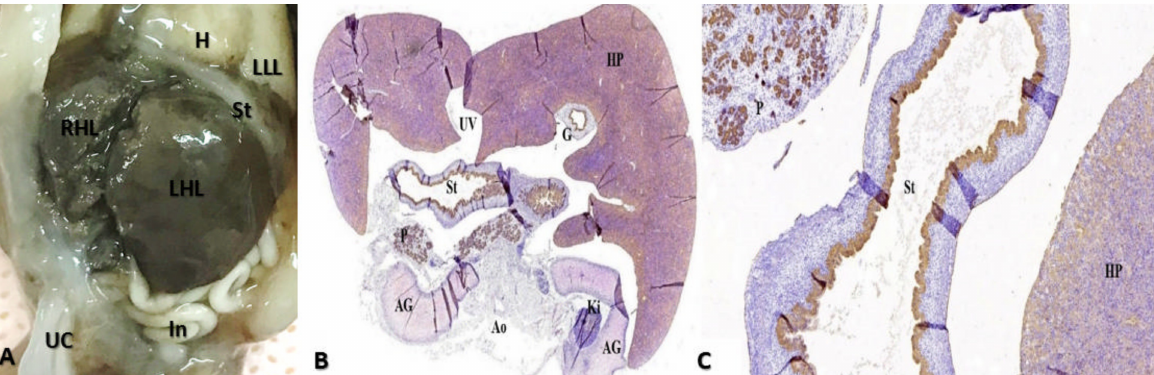
Figure 8. Anatomic and histopathological aspects of FT organs. ( A ): Anatomopathological specimen showing fetal liver which occupies most of the abdominal cavity. ( B , C ): Transverse section at the level of the abdomen. We can identify: the hepatic parenchyma located anteriorly, with the disorganized hepatocyte cords, weakly immunolabeled with CK AE1-AE3, the stomach (St) at which the gastric epithelium was intensely immunolabeled, the pancreas (P) with immunoreactive acinar cells, the two adrenal glands (AG) and one kidney (Ki). Moreover, part of gallbladder (G) are immunolabeled. Immunohistochemical staining with anti-CK antibody AE1-AE3; ( B ) the hepatic parenchyma (HP) is observed, with the disorganized hepatocyte cords, weakly immunolabeled with CK AE1-AE3, the stomach (St) with the gastric epithelium intensely immunolabeled, the pancreas (P) with immunoreactive acinar cells. Immunohistochemical staining with anti-CK antibody AE1-AE3. CK: Cytokeratin, HP: hepatic parenchyma, UV: umbilical vein, G: gallbladder, St: stomach, AG: adrenal glands, Ao: Aorta, Ki: kidney, In: intestine, UC: umbilical cord, RHL: right hepatic lobe, LHL: left hepatic lobe, LLL: left lower lobe of the lung.